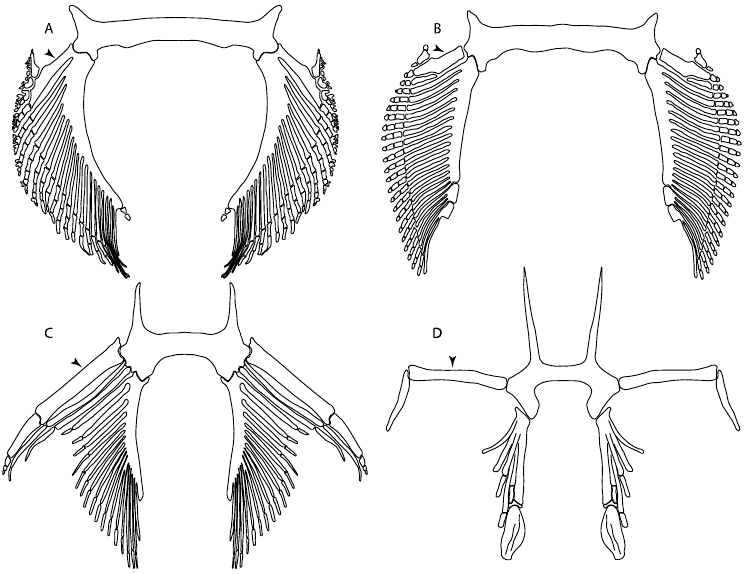
Figure 47. Dorsal view of pelvic girdle. State (0): ( A ) Platyrhina sinensis (AMNH 44055) redrawn and modified from de Silva et al. Text-Figure 2D in [10]. ( B ) Zapteryx brevirostris (uncatalogued material). State (1): ( C ) Raja clavata (BRC–Raja); ( D ) † Cyclobatis oligodactylus. (NHMUK PV P-601).